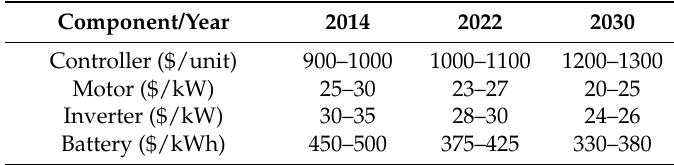
Table 2. Hybrid and electric powertrain component price forecast